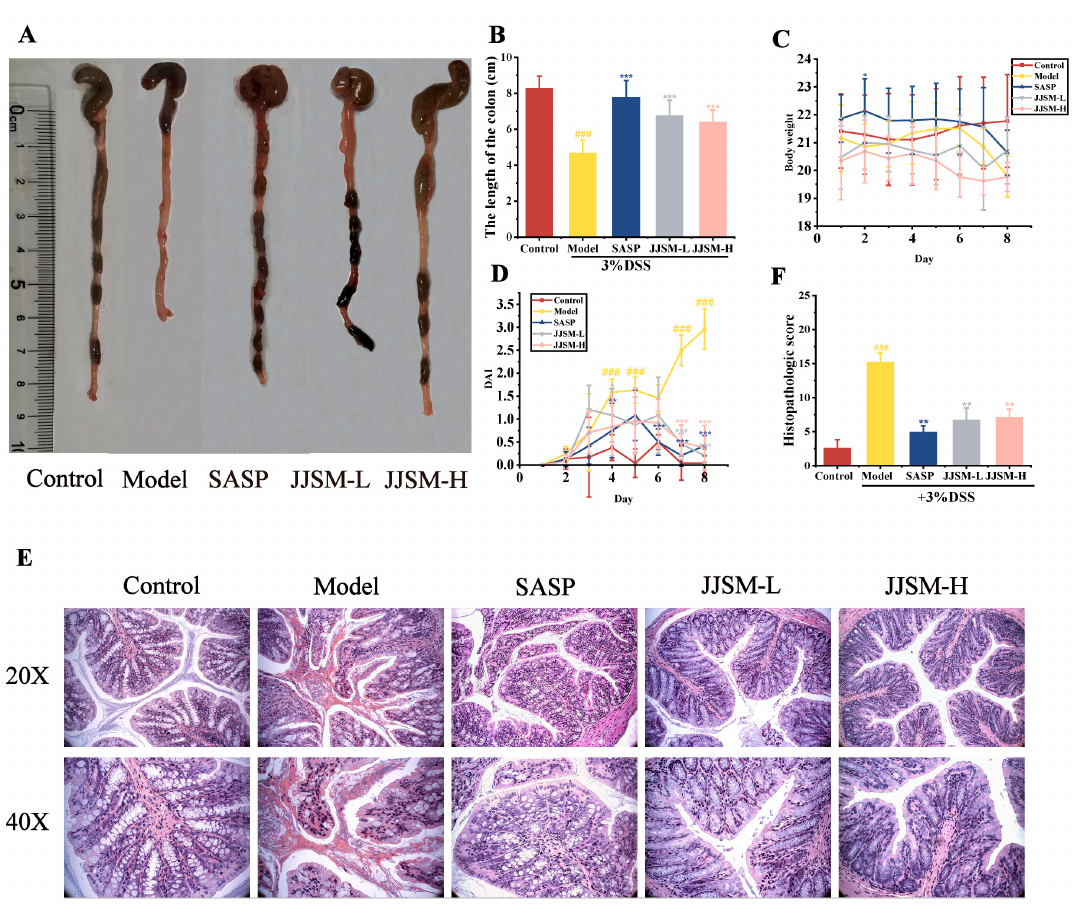
Figure 1. JJSM ameliorated the clinical symptoms of DSS-induced colitis in mice. ( A ) Macroscopic view of colon length; ( B ) Colon length; ( C ) Changes in body weight; ( D ) DAI scores. Effect of JJSM on histopathological changes. ( E ) Hematoxylin and Eosin (H & E)-stained representative colonic tissues; ( F ) Histological score. Data are presented as the mean ± S.D. ### p < 0.001 vs. Control group; * p < 0.05, ** p < 0.01 vs. Model group, *** p < 0.001 vs. Model